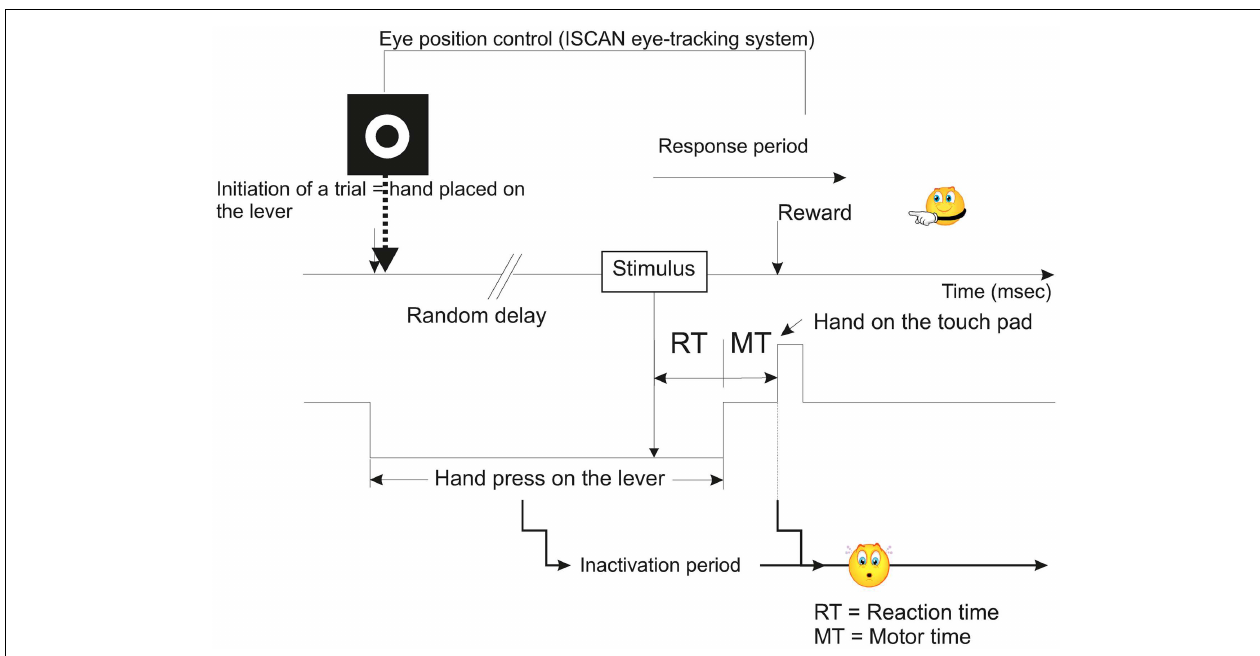
FIGURE 1 | Schematic representation illustrating the temporal course of a typical trial of the multisensory and sensorimotor integration task used in the present study (modified from Smith and Olszyk, 1997) . See also Movie S1 in Supplementary Material.